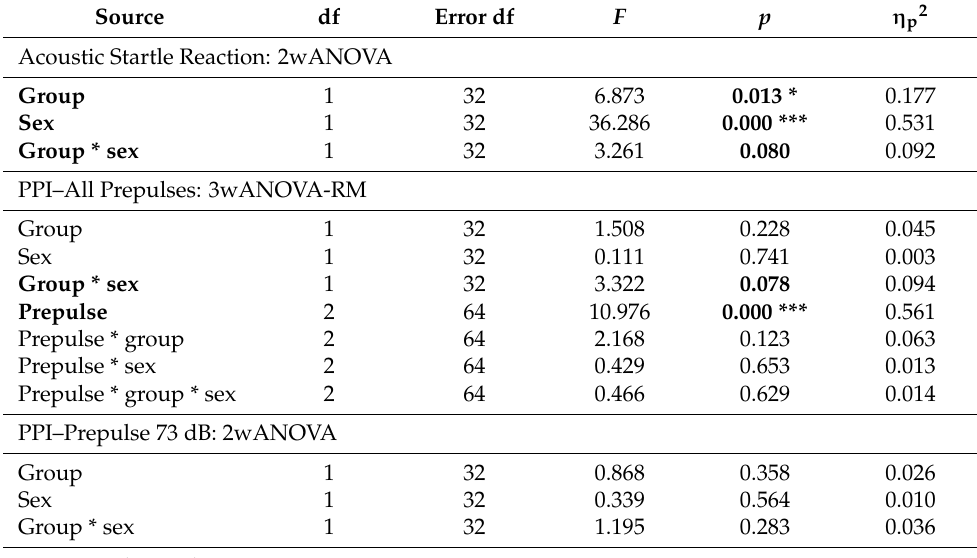
Table A9. Three-way ANOVA-RM, two-way ANOVA, and t -test table for the acoustic startle reaction and prepulse inhibition